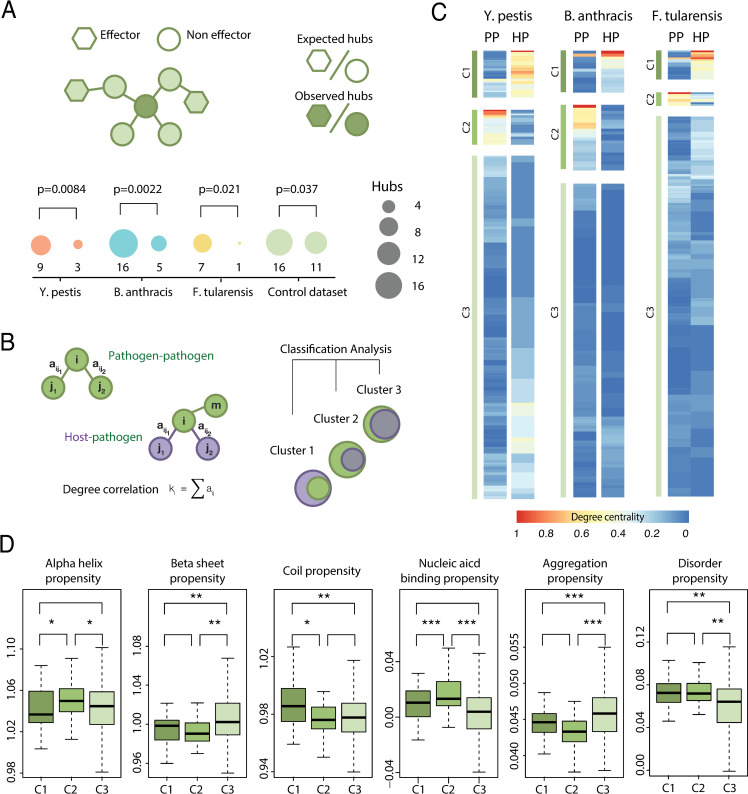
Hubs in the host-pathogen interactome are largely isolated in the pathogen network.(A) We computed the degree of interaction for all proteins in Y. pestis, B. anthracis and F. tularensis and asked whether the number of hubs (here defined as the 5% of most connected proteins) differ between effectors and non-effectors. In all cases, the number of hubs observed is significantly lower than expected. Similar results were obtained in the control database. The p-values were computed using a χ2-square test of independence to assess the probability of observing such a large discrepancy (or larger) between observed and expected values. Effectors were defined using EffectiveDB with a stringency threshold of 0.95 [52]. All comparisons remain statistically significant in the threshold interval 0.90–0.99 (p<0.05). (B) We compared the degree centrality of bacterial proteins in the pathogen and the host-pathogen interactomes. Based on the results obtained, we classified the bacterial proteins in clusters, according a k-means clustering algorithm. (C) Based on this clustering, three different groups were identified: proteins that have a high number of interactions in the host-pathogen interactome but are highly isolated in the pathogen interactome (C1 cluster), proteins that are isolated in the host-pathogen interactome but deeply connected in the pathogen interactome (C2 cluster) and proteins that are mainly isolated in both clusters (C3 cluster). (D) The three clusters identified previously have distinctive structural properties. Proteins in C1 cluster are enriched in coil structure, which favors the presence of disordered regions; proteins in C2 cluster are enriched in alpha helix structure, which favors interaction with nucleic acids and proteins in C3 cluster are enriched in beta sheet structure, that favors aggregation. * p<0.05; ** p<0.01; ***p<0.005 using a Mann–Whitney U-test with α = 0.05.